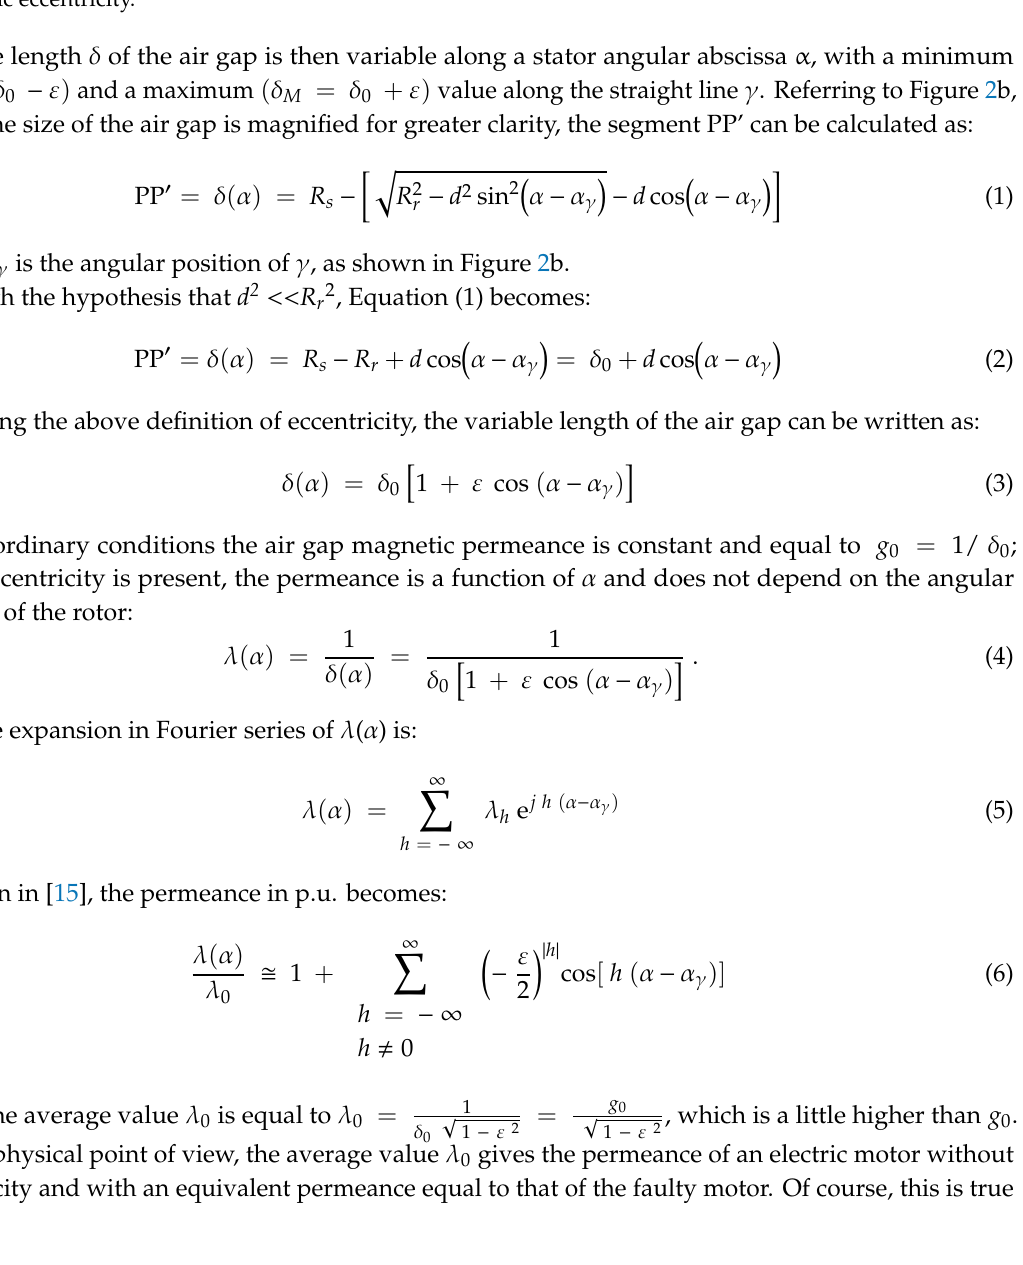
Figure 2. Schematic cross section of the considered PM motor type, without ( a ) and with ( b ) rotor static eccentricity.